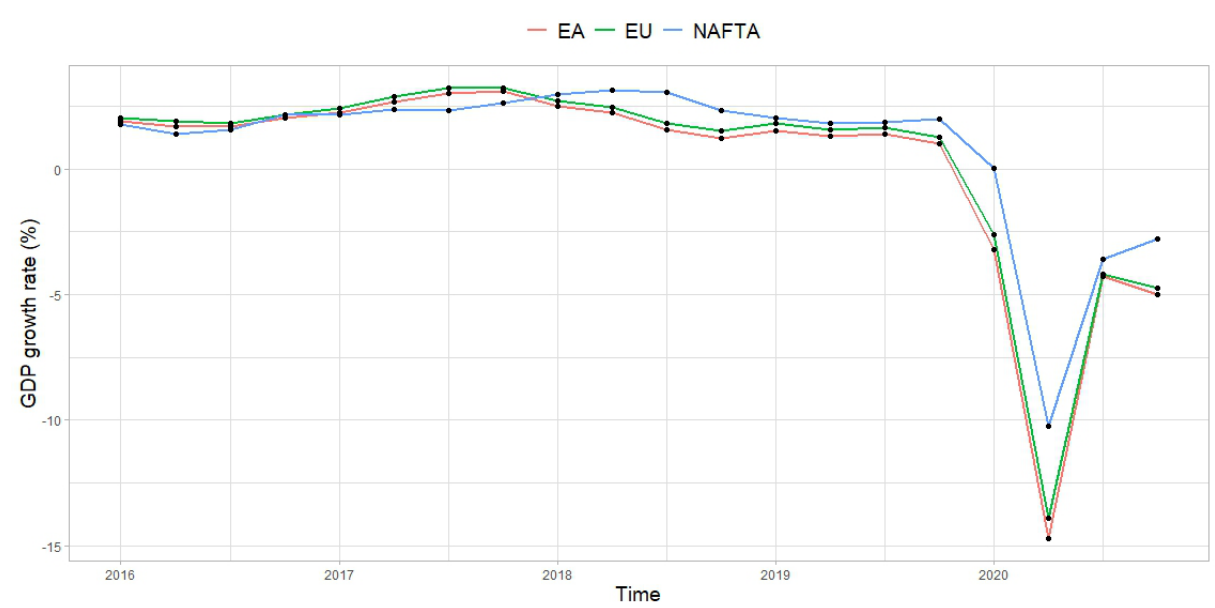
Figure 1. Growth Rates of Gross Domestic Product compared to the same quarter of previous year, seasonally adjusted data (1st quarter 2016–4th quarter